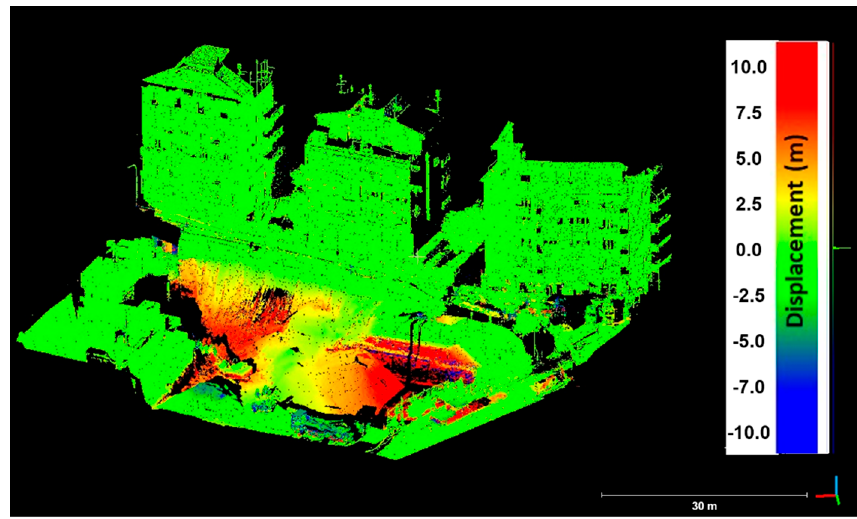
Figure 7. 3D distance map, in terms of M3C2 distance (computed vertically), obtained through the comparison between point clouds acquired on February 17th and 18th, 2018, Red areas indicate fill of material (about 8 m along the vertical component) due to the emergency stabilization works.